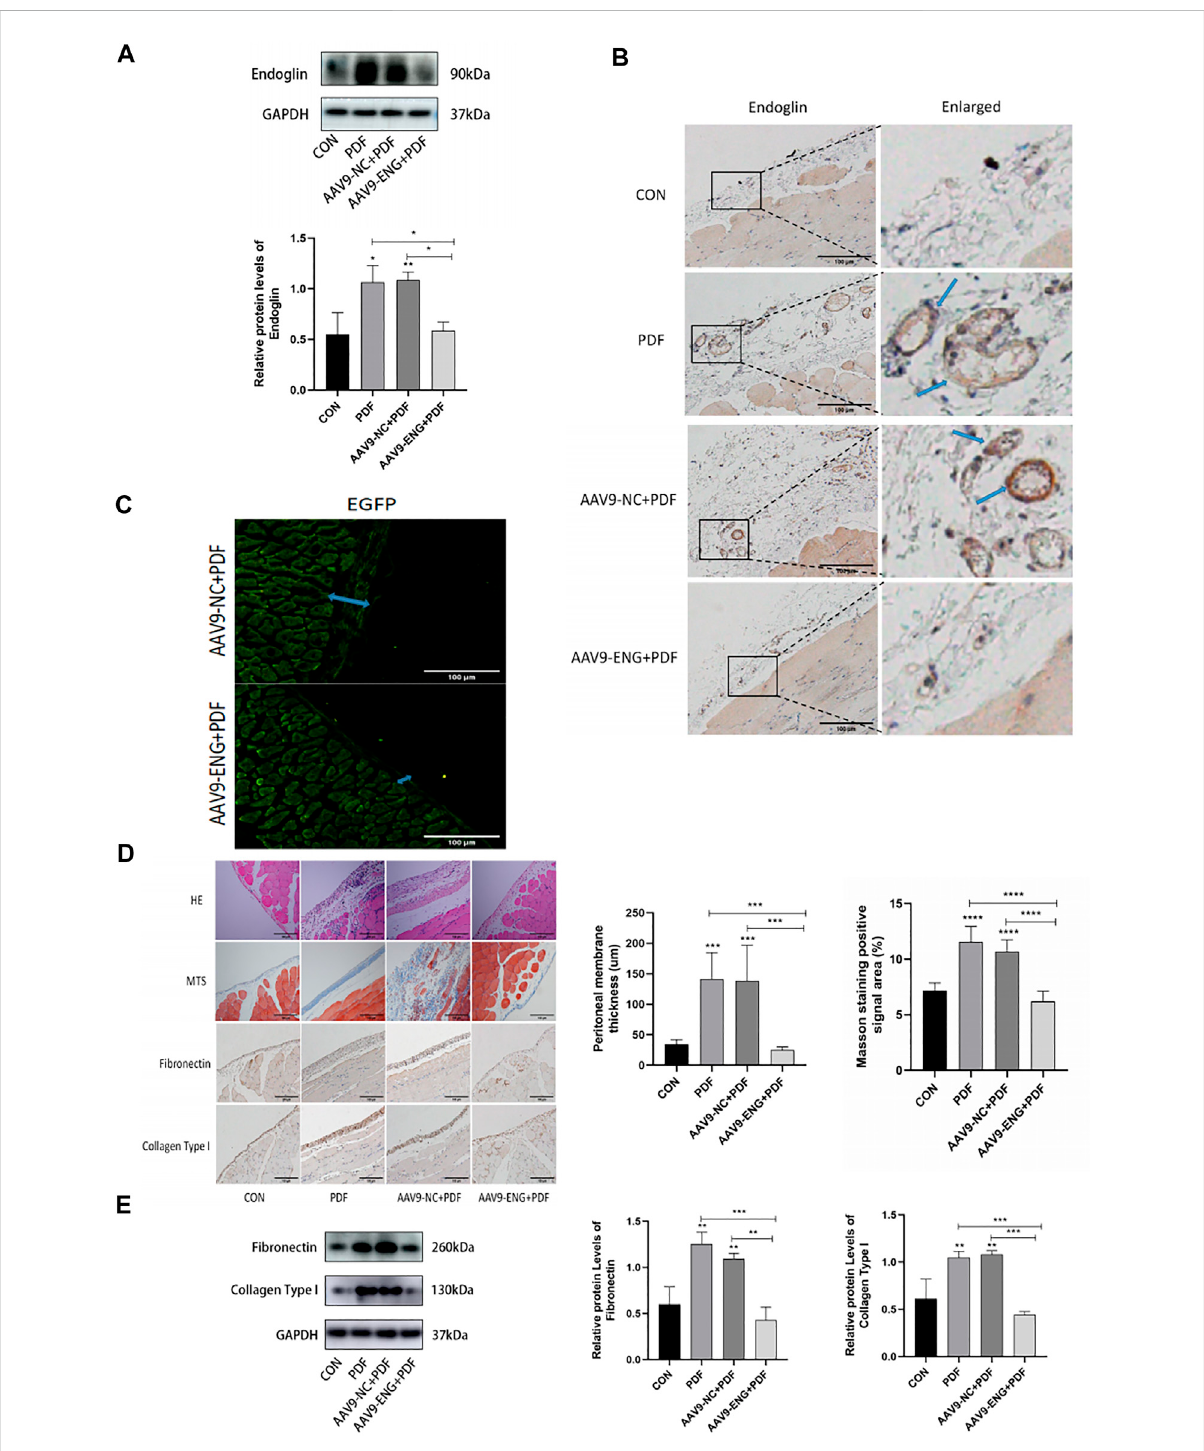
FIGURE 2 Knockdown of endoglin attenuated PD-induced PF. (A) Western blot analysis of endoglin protein levels in different groups of rats. (B) Representative immunohistochemical staining images of endoglin in different groups of rats. Scale bar = 100 μ m. (C) Fluorescent images of frozen peritoneum sections. Scale bar = 100 μ m. (D) HE, Masson ’ s trichrome staining and immunohistochemical staining images of Fibronectin and Collagen Type I protein indifferent groups. Scale bar = 100 μ m. (E) Immunoblot analysisand corresponding statisticalgraph of Fibronectin and Collagen Type I. n = 6. All quantitative data are expressed as mean ± SD, * p < 0.05, ** p < 0.01, *** p < 0.001, **** p <